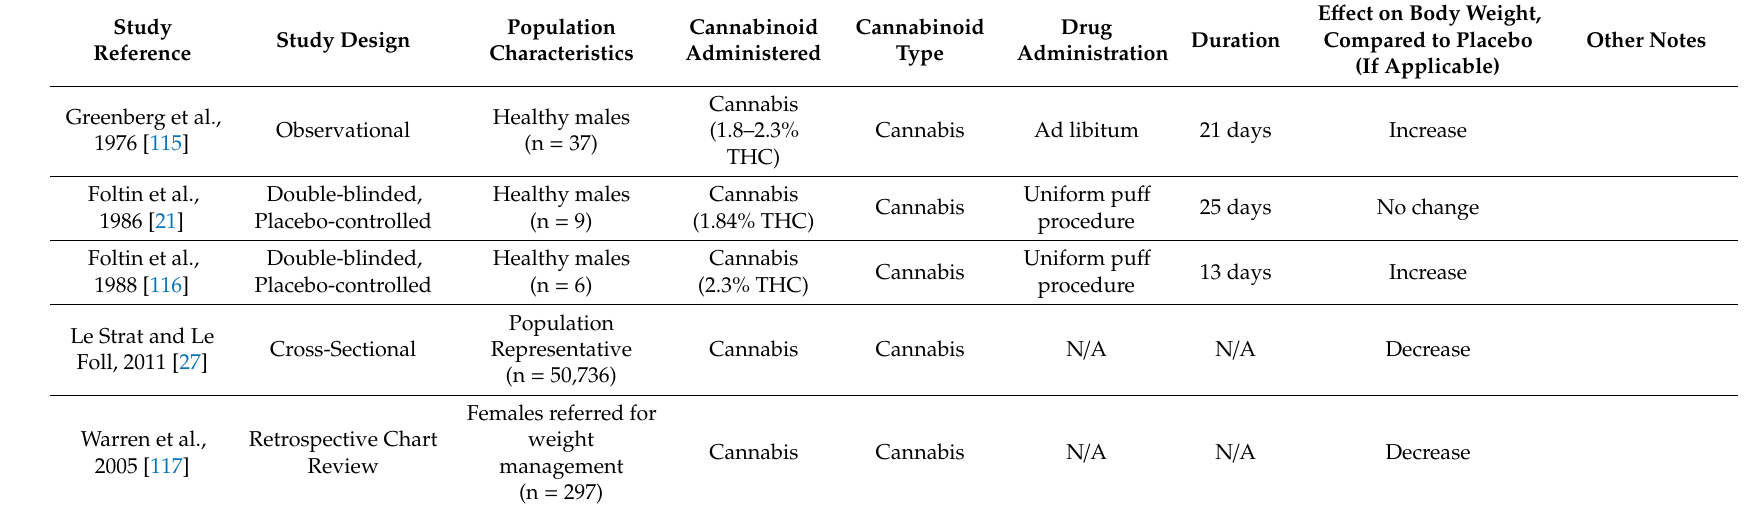
Table 2. Summary of Evidence: Clinical Studies of Cannabinoid Drug E ff ect on Body